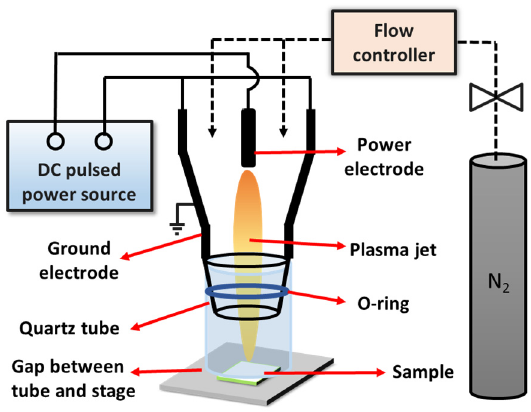
Figure 1. Schematic of the atmospheric-pressure plasma jet (APPJ) setup.